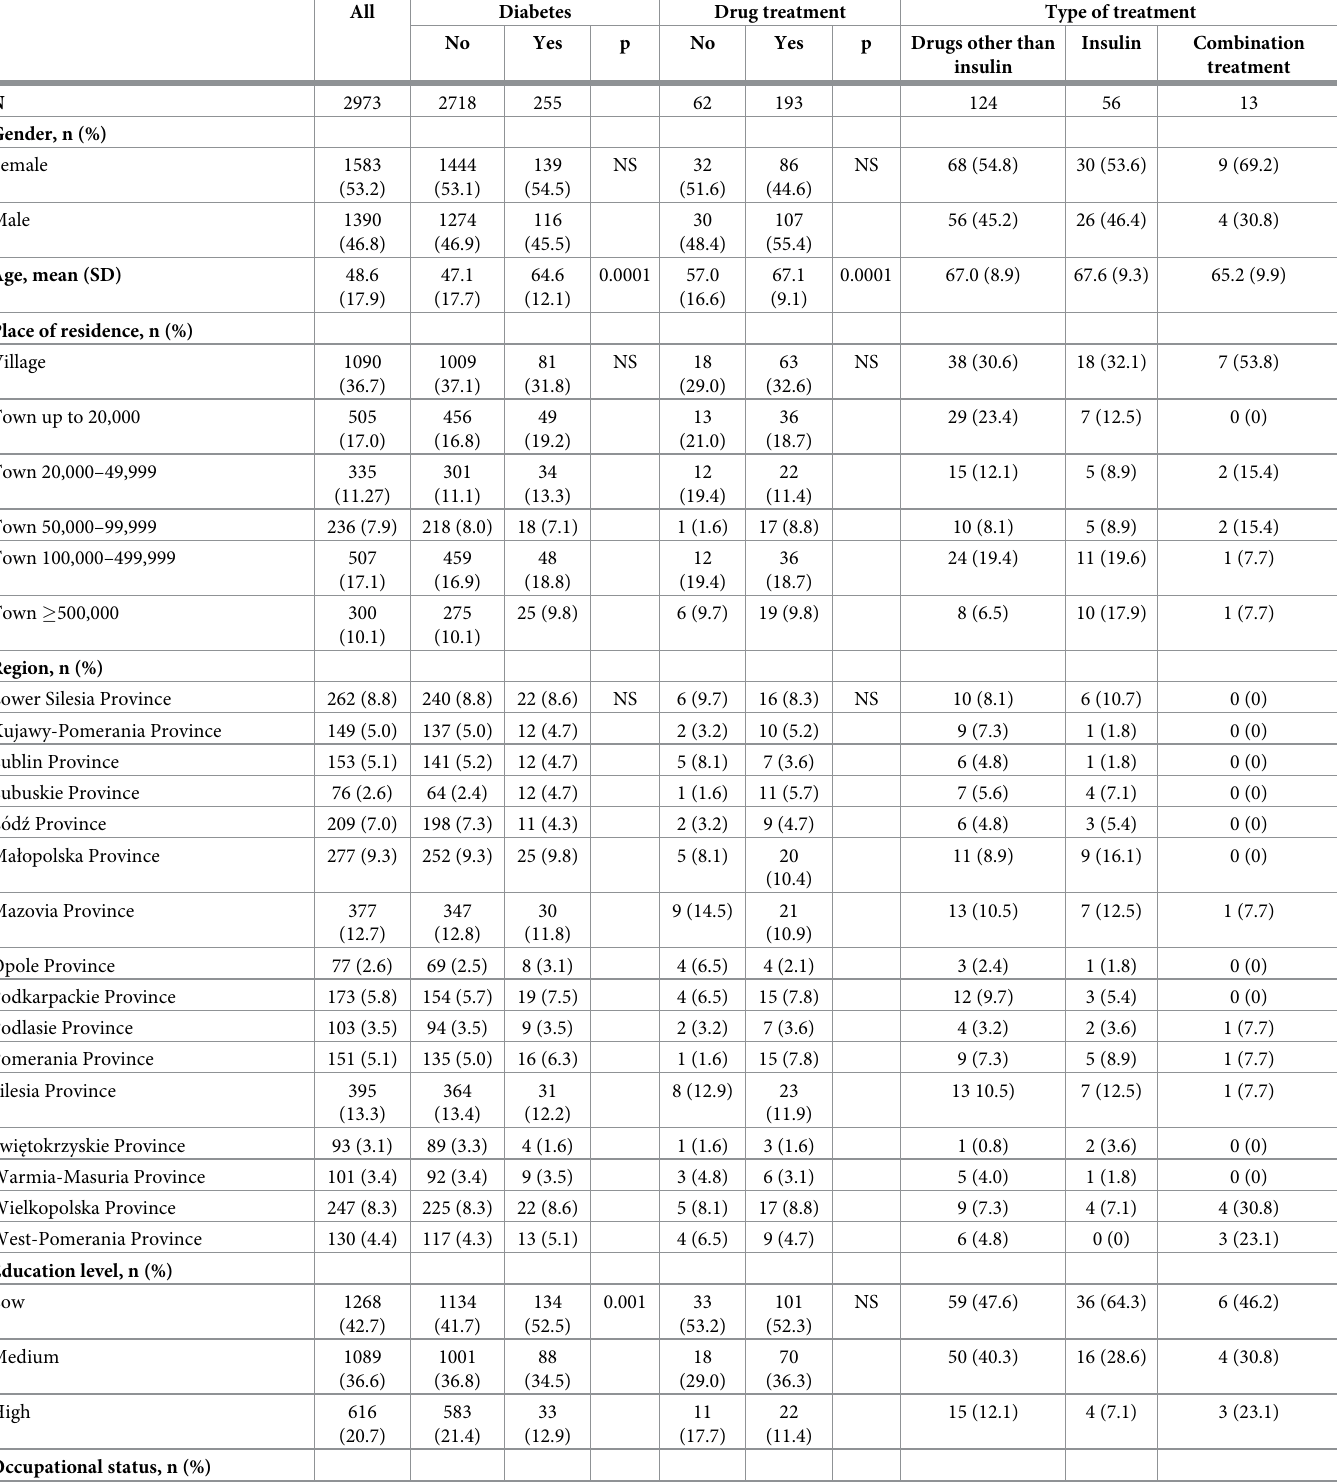
Table 1. Characteristics of respondents according to diabetes and treatment